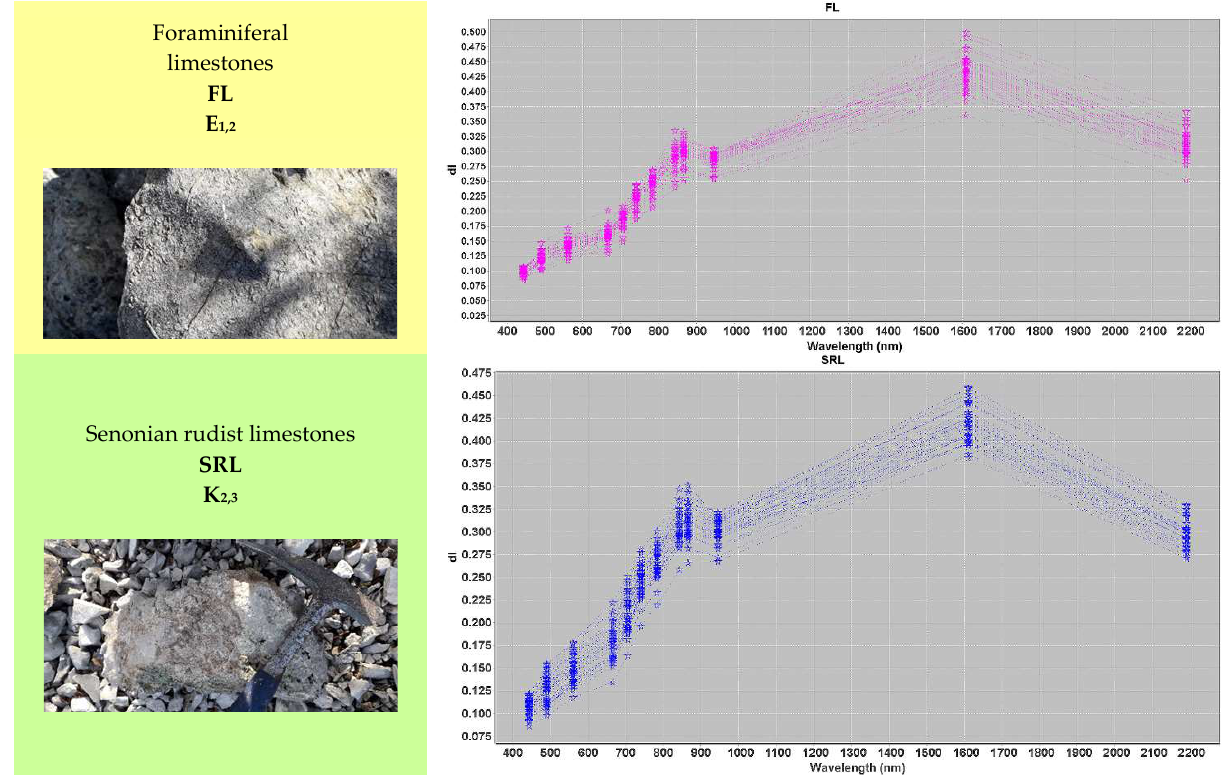
Figure 6. Six lithological unit spectral signatures which were read according to flowchart shown in Figure 3.